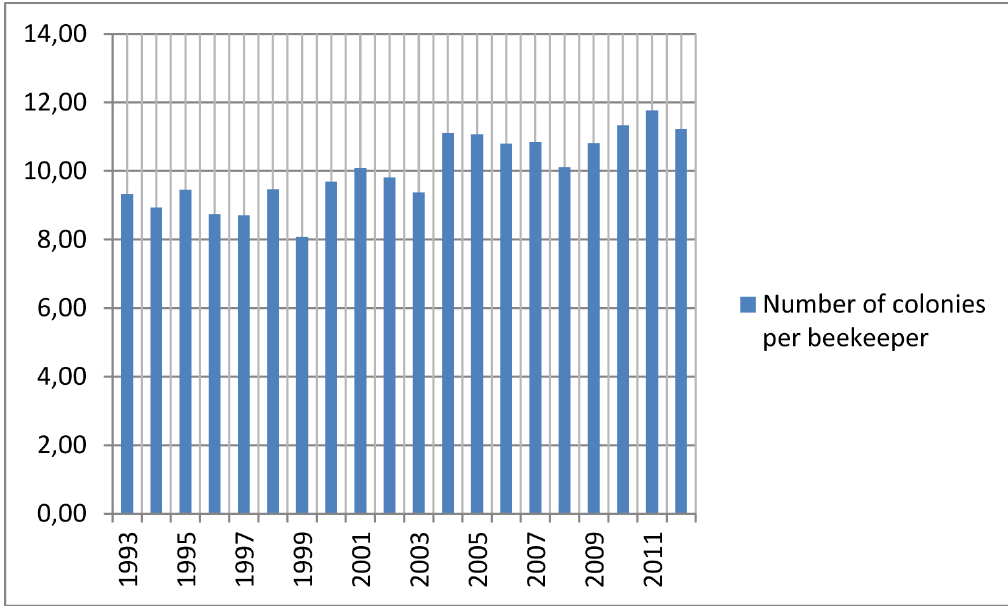
Fig. 2. Change in the number of bee colonies per beekeeper the Czech Republic (Situational and outlook report on bees, November